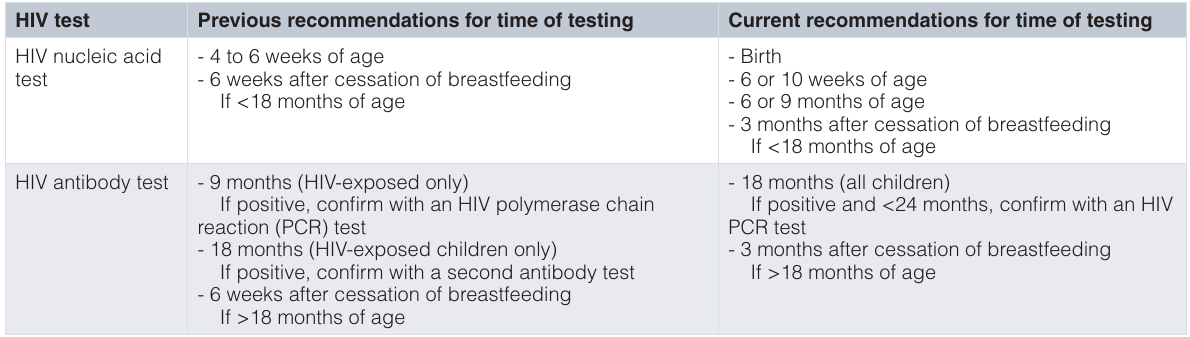
Table 1. Updated recommendations for HIV testing of infants and